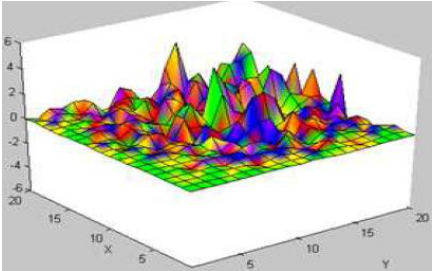
Figure 3: 3D representation of a multi-scale surface using Daubechies wavelet with multi-scale parameters ( ν 1 =1.3; ν 2 =1.3; γ = 0.2 cm), P=10 4 MULTISCALE SURFACE MODEL FOR